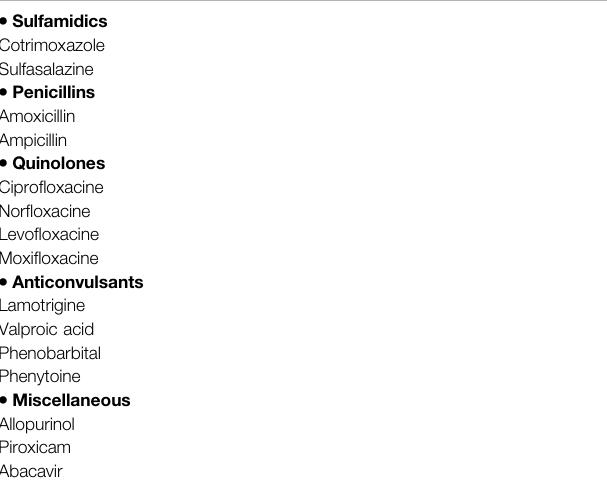
TABLE 4 | Drugs associated with epidermal necrolysis (Stevens – Johnson and Lyell